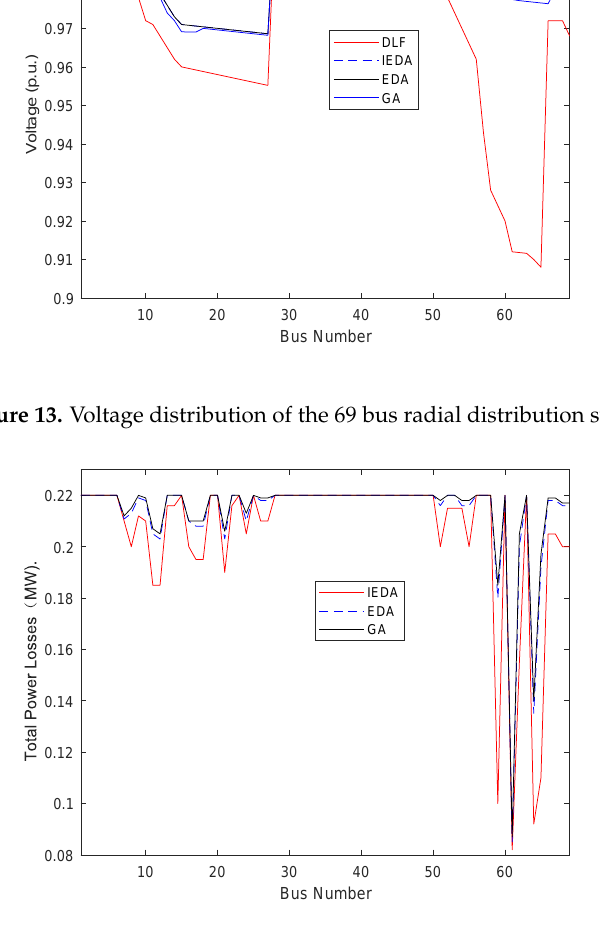
Figure 14. Distribution of network loss of each bus in the 69 bus radial distribution